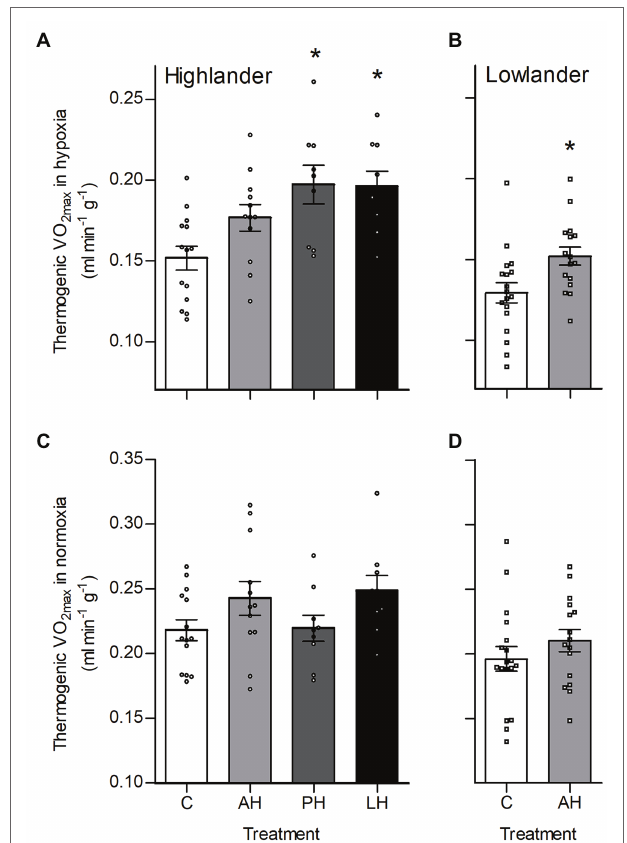
FIGURE 2 | Developmental hypoxia increased thermogenic capacity in hypoxia in deer mice native to high altitude. Thermogenic capacity was measured as the maximal rate of O 2 consumption (V ̇ O 2max ) during acute cold ( − 5 ° C) exposure in hypoxic heliox (~12 kPa O 2 ; A,B ) and normoxic heliox (~21 kPa O 2 ; C,D ). Lowland mice were unable to raise litters in the PH or LH groups. Bars indicate mean ± SEM and symbols represent individual values. Treatment groups are shown in Figure 1 with N as follows: 14 control (C), 12 AH, nine PH, and nine LH for highlanders; 18 C and 16 AH for lowlanders. *Significant pairwise difference from control within each population using Holm-Sidak